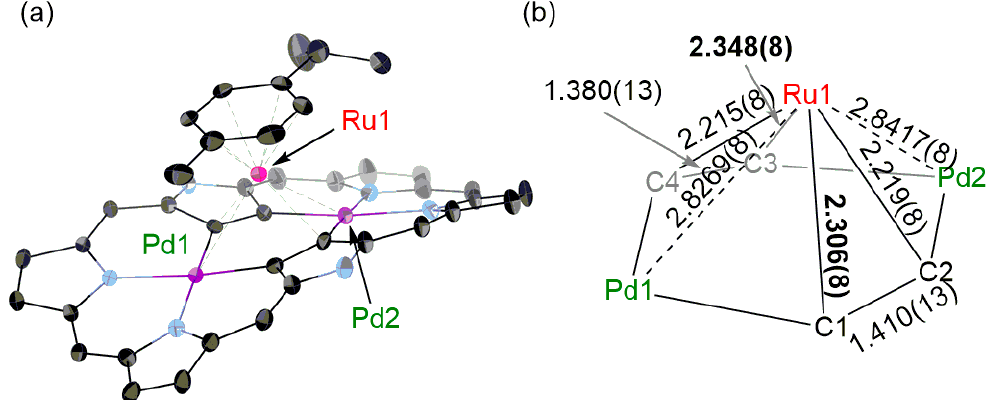
Figure 2. ( a ) X-Ray crystal structure of 4 . The thermal ellipsoids are 25% probability. One of two independent molecules is shown. Solvent molecules, pentafluorophenyl groups and hydrogen atoms are omitted for clarity. ( b ) Detailed bond lengths (unit: Å).